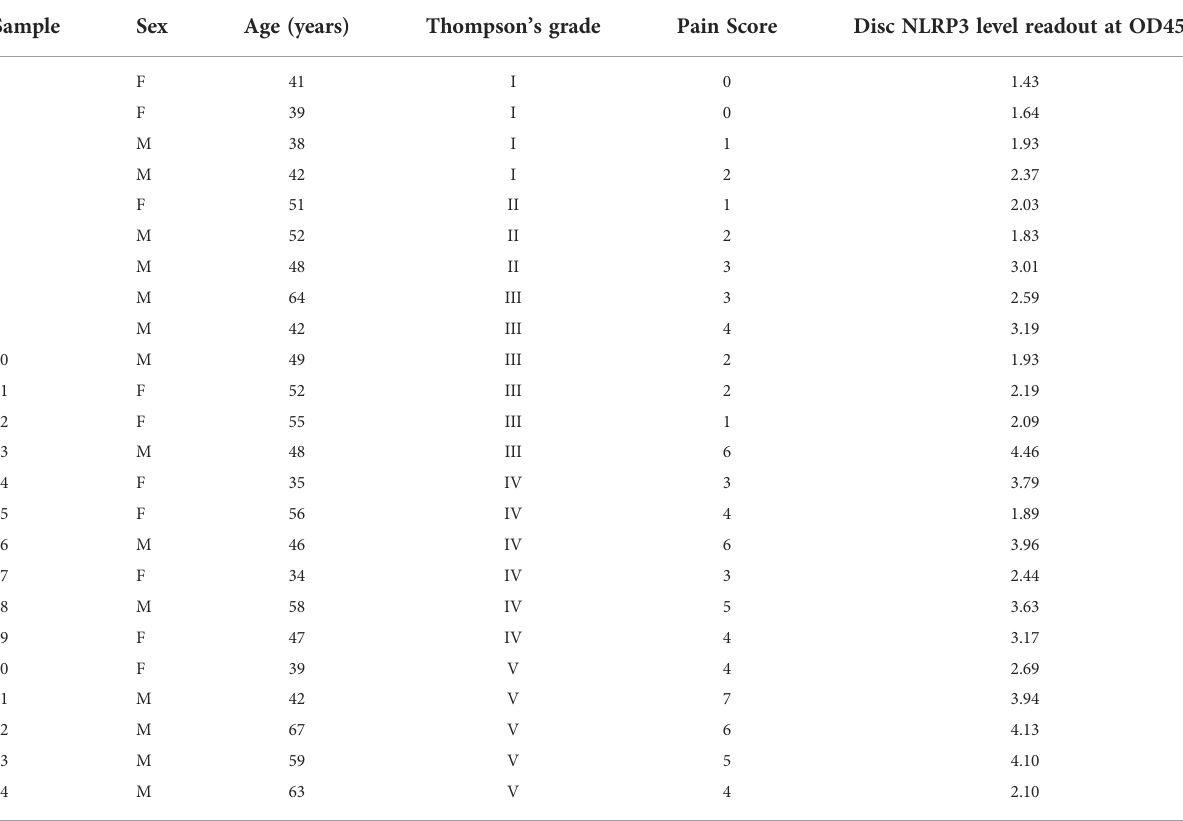
TABLE 1 Demographic information of Intervertebral disc